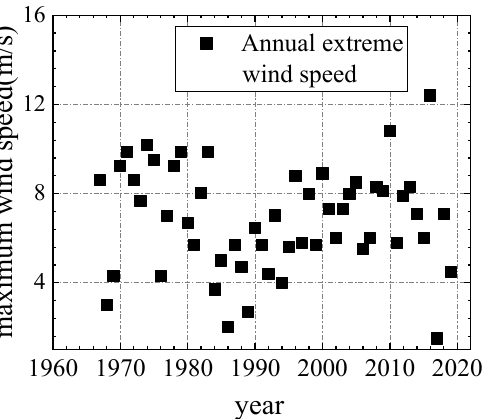
Figure 10. Annual maximum wind speed series of the constant winds in wind direction D14.